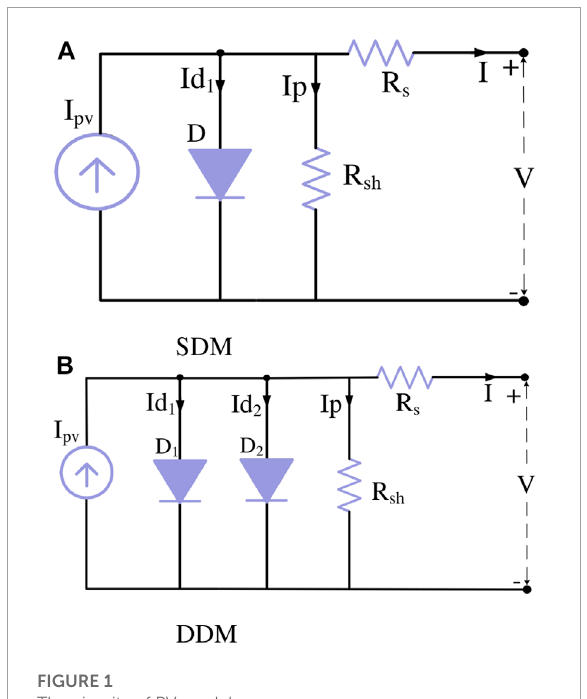
FIGURE 1 The circuits of PV models.